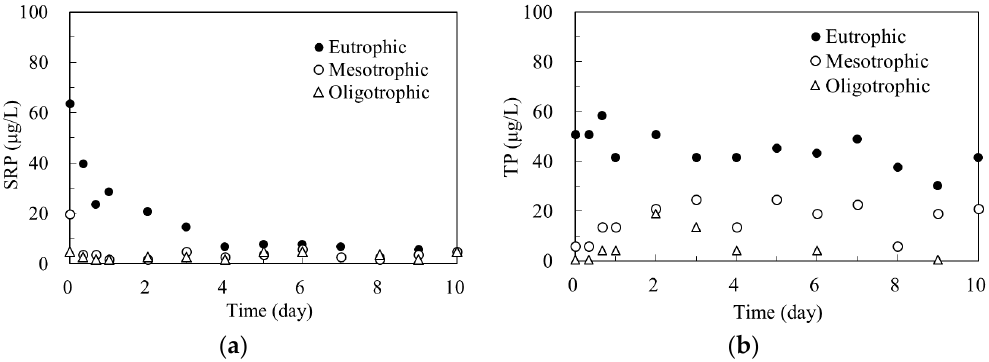
Figure 3. Changes of soluble reactive phosphorus (SRP) and total phosphorus (TP) concentrations in the microcosms. ( a ) SRP; ( b ) TP.